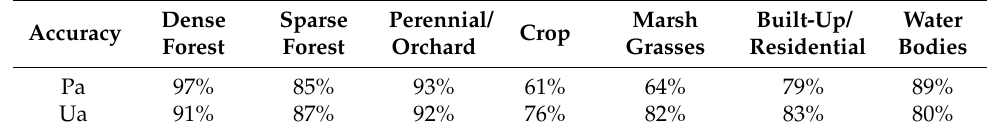
Table 3. Accuracy of classes of the 2005 land cover map.